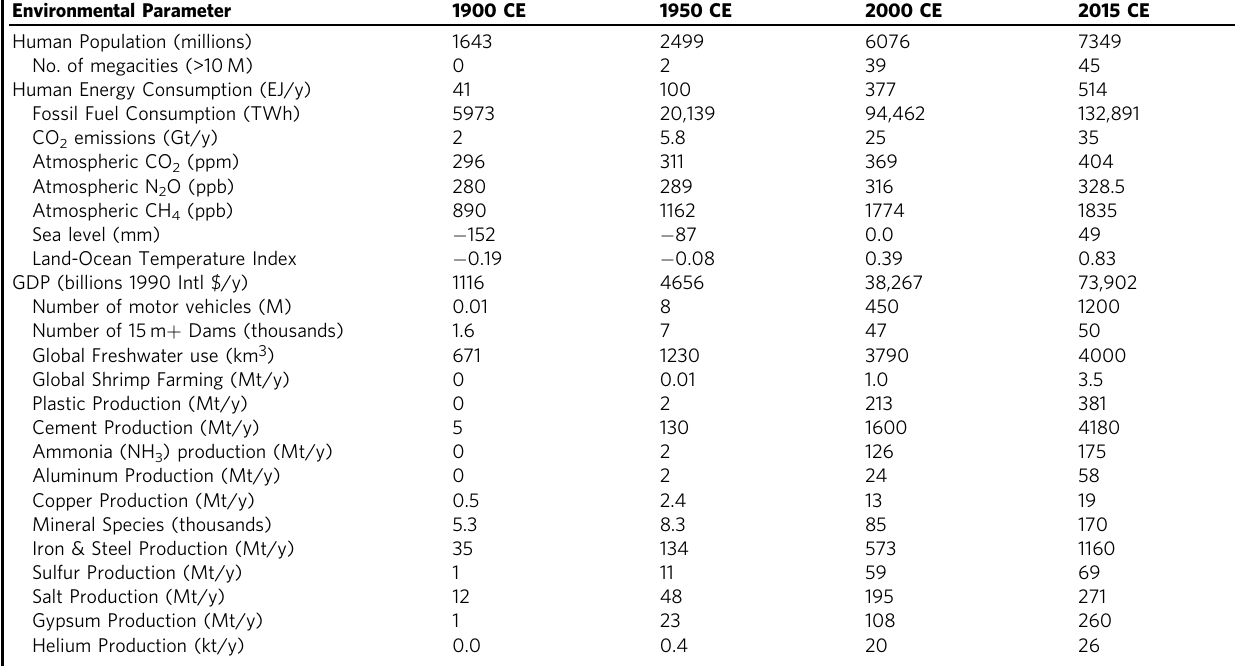
Table 2 Selection of key global environmental parameter values spanning the Holocene-Anthropocene transition. Environmental